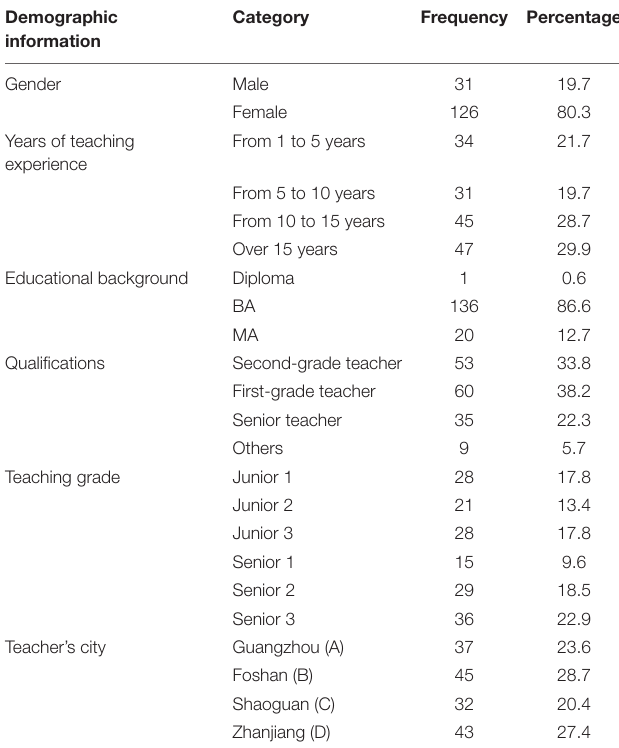
TABLE 2 | Demographic information for the teachers who participated in the